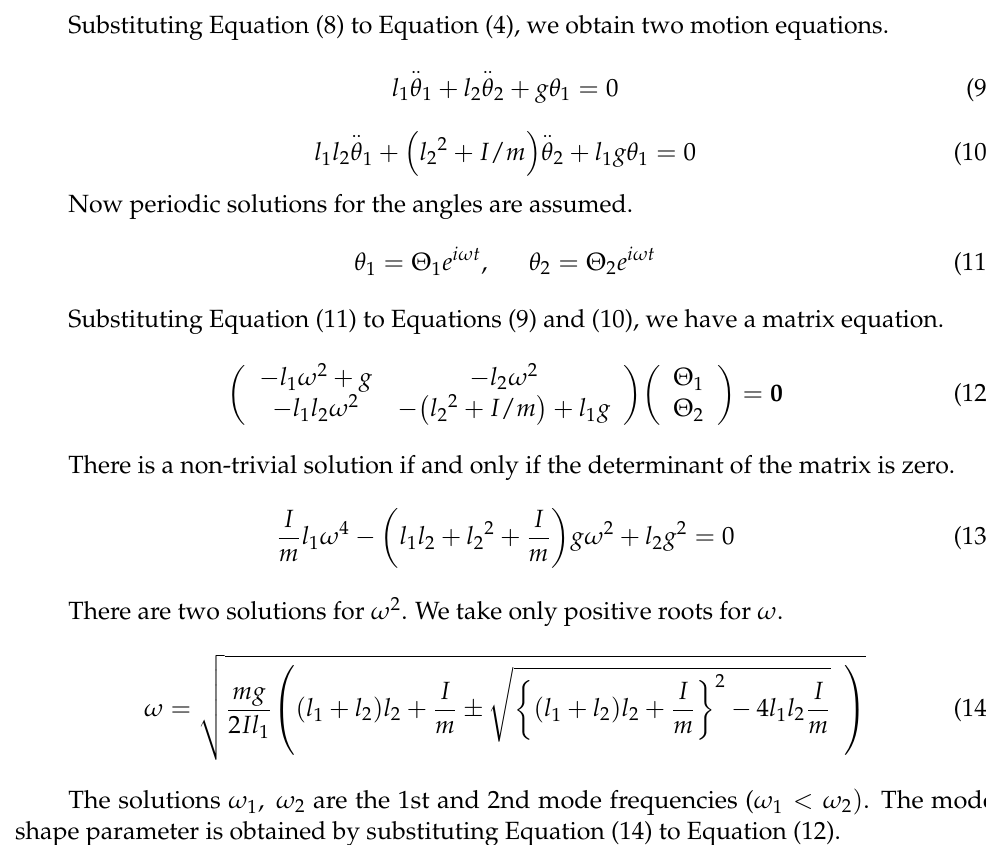
Figure 6. Double pendulum model of the suspended launcher. When the launcher is settled at the equilibrium state, 𝜃 (cid:2869) = 𝜃 (cid:2870) = 0 .